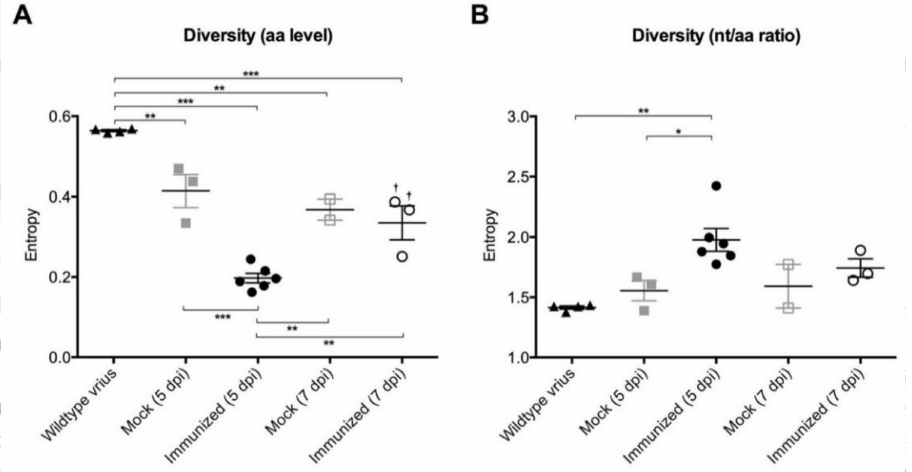
Figure 4. Lung viruses of vaccinated mice showed a reduction in LAH sequence diversity. ( A ) Shannon Diversity index of LAH amino acids. †: corresponding to the samples with the same labeling in Figure 5B and Figure S2A. ( B ) Nucleotide to amino acid entropy ratios of the Shannon Diversity calculated for each sample. * p < 0.05, ** p < 0.01, and *** p < 0.001. Error bars represent